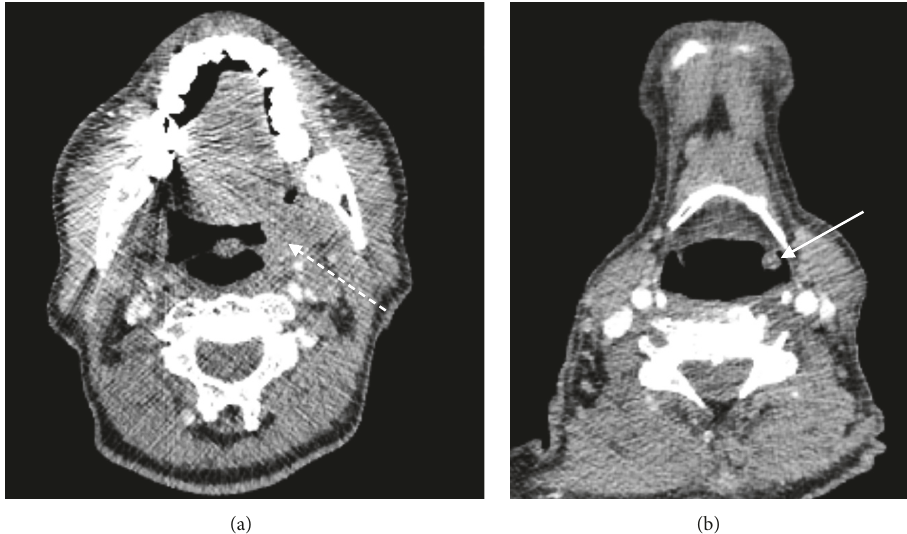
Figure 4: (a) Axial CT image with contrast at the level of the suprahyoid neck revealing an enlarged left palatine tonsil (dashed white arrow). (b) Axial CT image with contrast at the level of the hyoid bone which demonstrates a subcentimetre mucosal soft tissue nodule in the left aryepiglottic fold (white